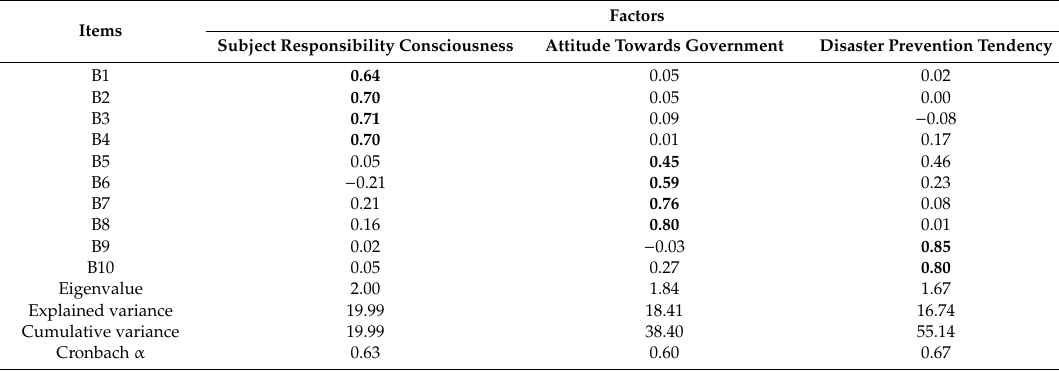
Table 5. Component matrixes of awareness of disaster risk reduction after rotation.